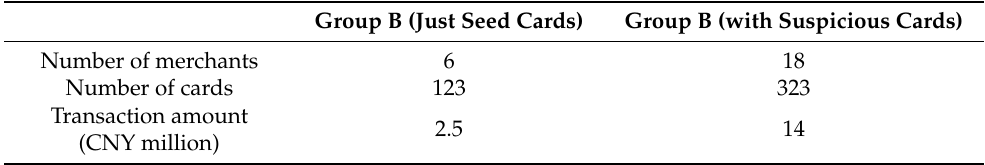
Table 6. Model effect of this model.